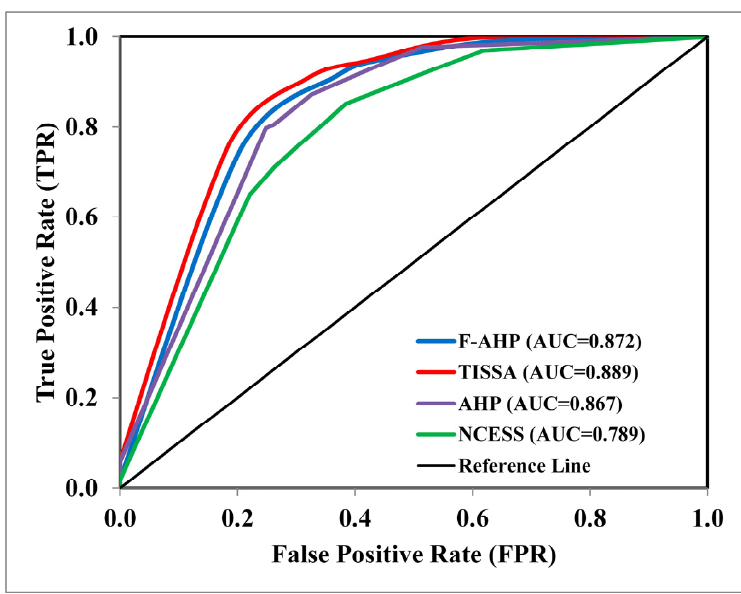
Figure 9. The ROC curves for the validation dataset.